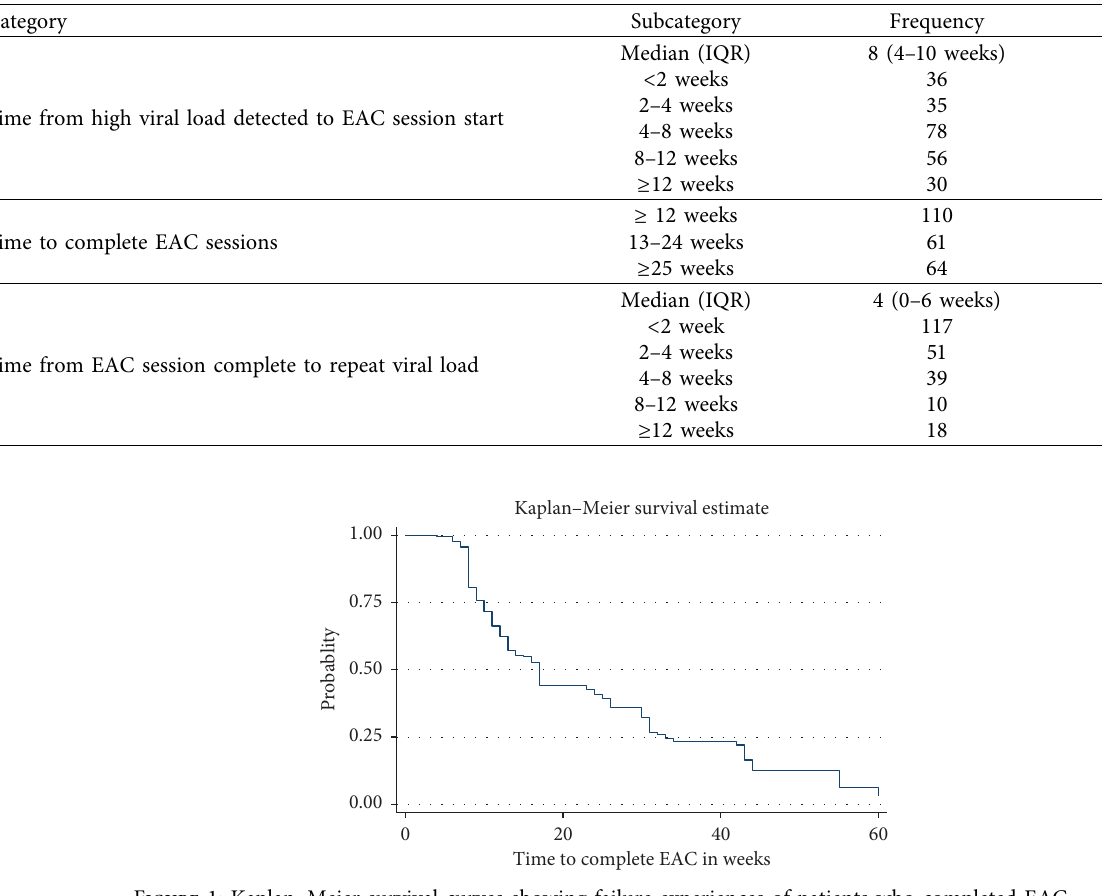
Table 4: Time from high viral detected to EAC session start and time from EAC complete to repeated viral load.